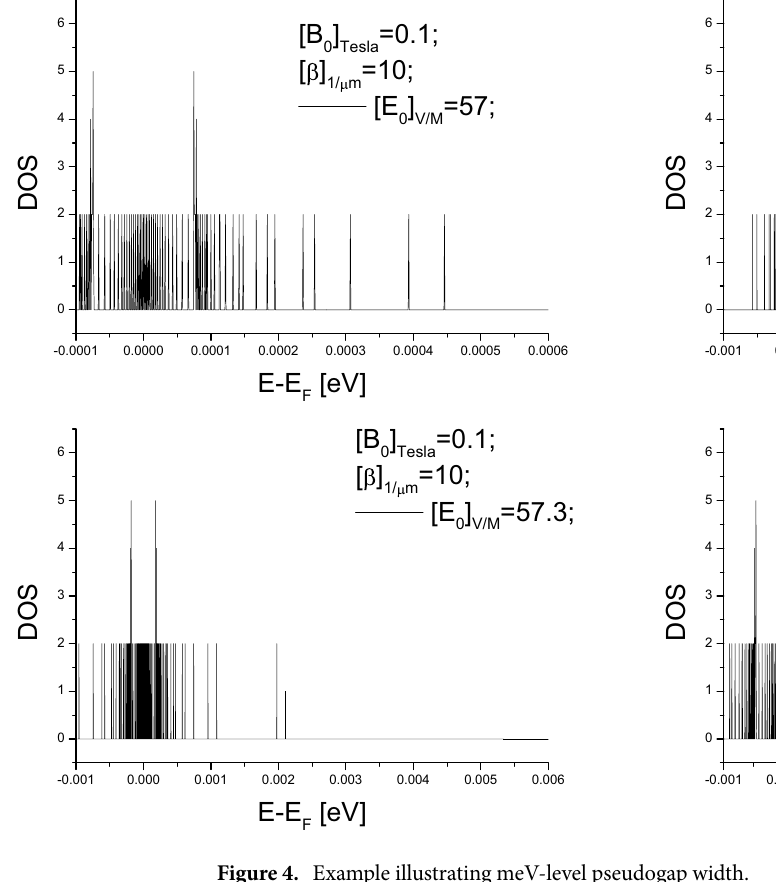
Figure 4. Example illustrating meV-level pseudogap width.